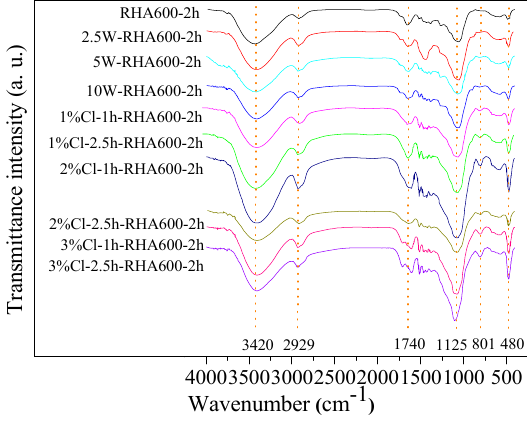
Figure 3. FTIR spectra of RH with and without various pretreatments.